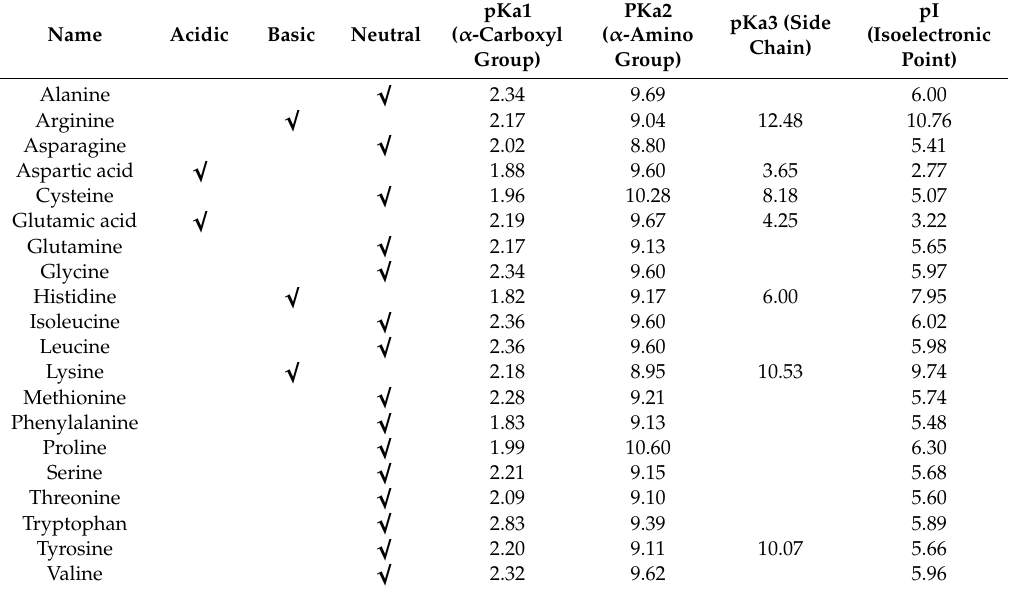
Table 2. Enlists all 20 proteogenic amino acids. It highlights acidic, basic and neutral amino acids with their pKa and pI values. Data collected from Haynes, William M., 2014 [159].